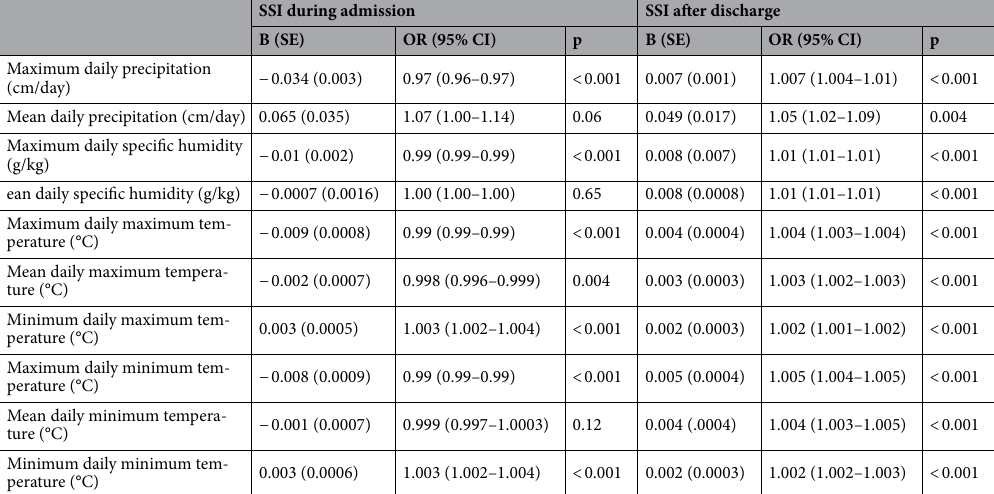
Table 3. Univariable multinomial analysis coefficients and odds ratios for climate predictors. Specific humidity and precipitation units were converted to g/kg from kg/kg and cm/day from mm/day, respectively, to reduce exponential power of odds ratios. Selection for inclusion in the multivariable analysis took into consideration variable effect size, significance, and literature support for